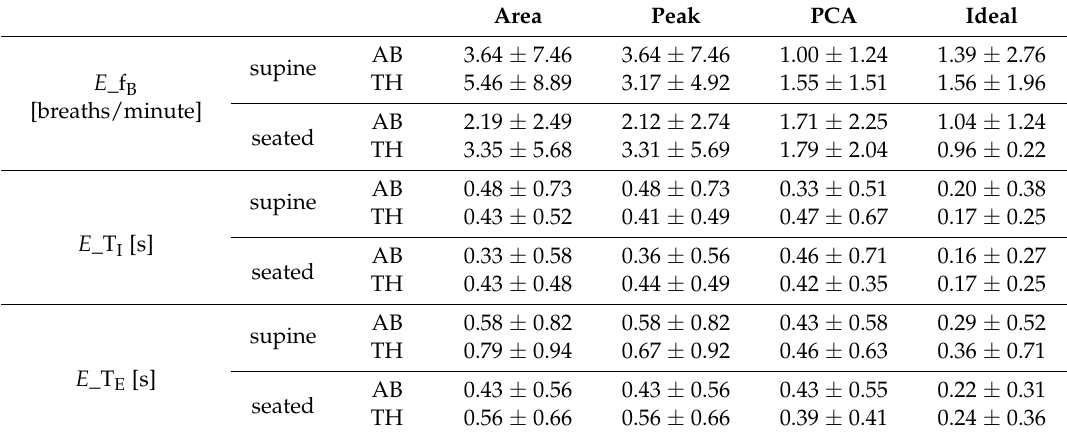
Table 2. Absolute errors of breathing frequency ( E _f B ), Inspiratory time ( E _T I ) and expiratory time ( E _T E ) obtained for the device with respect to OEP, using best component-selection methods (“Area” and “Peak”), PCA-fusion method and “Ideal”